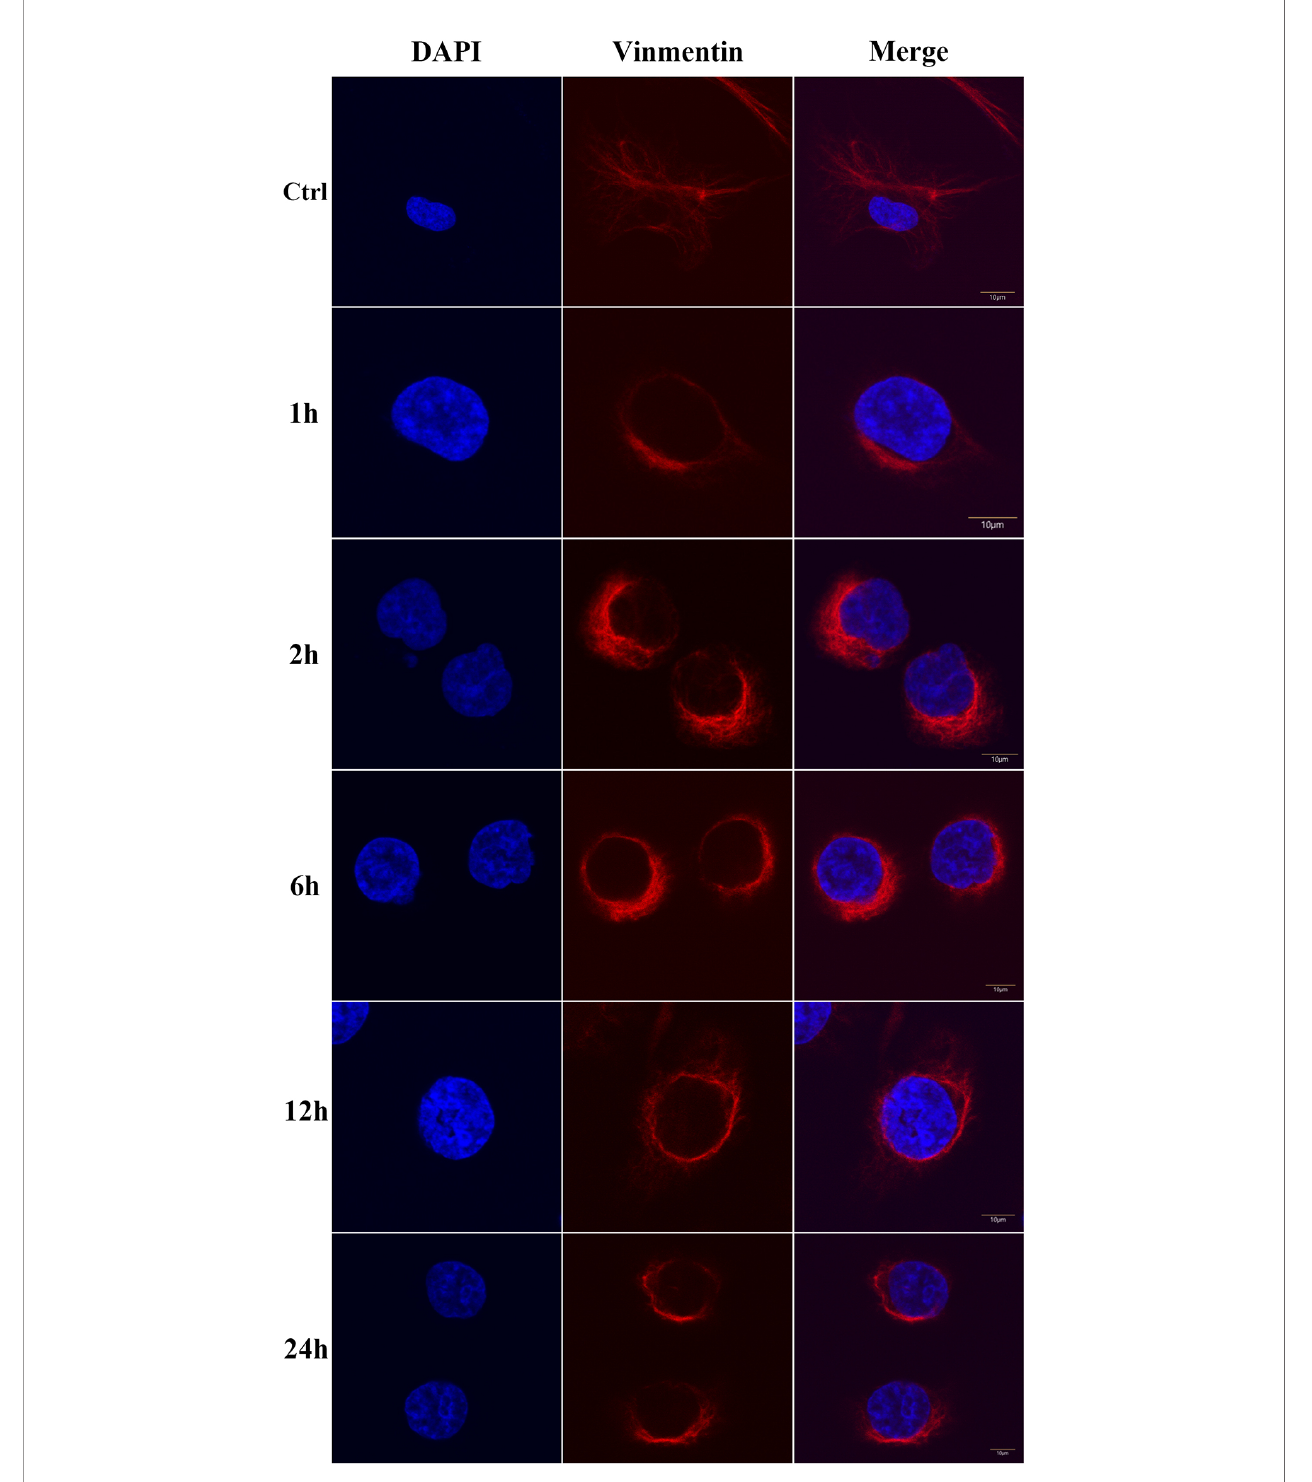
FIGURE 1 | Vimentin rearrangement in human brain microvascular endothelial cells (HBMEC) infected with dengue virus (DENV)-2 for different periods of time. Ctrl means control group. All scale bars are 10 m m.